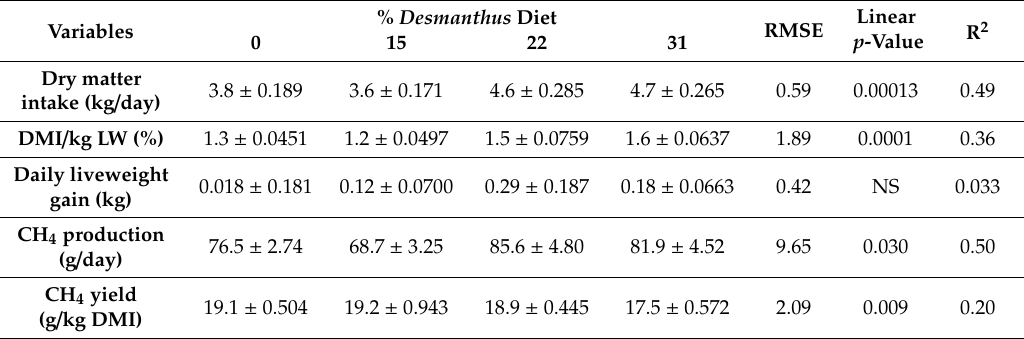
Table 3. Relationship between the dry matter intake (kg / day), DMI per kg LW (%), daily liveweight gain (kg), CH 4 production (g / day), CH 4 yield (g / kg DMI) and the percentage of Desmanthus DM in the diet (means ± s.e.).